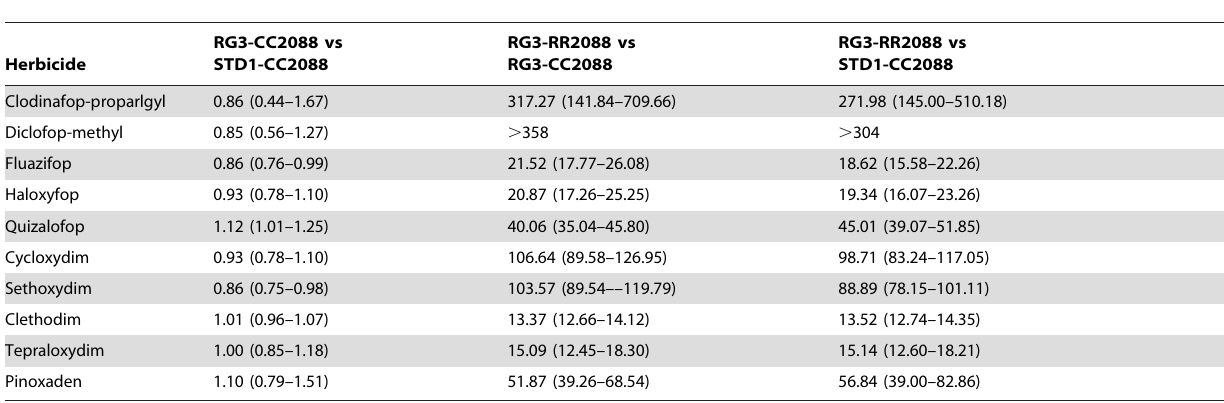
Table 3. Estimated resistance factors for 10 ACCase herbicides and different 2088 ACCase genotypes.